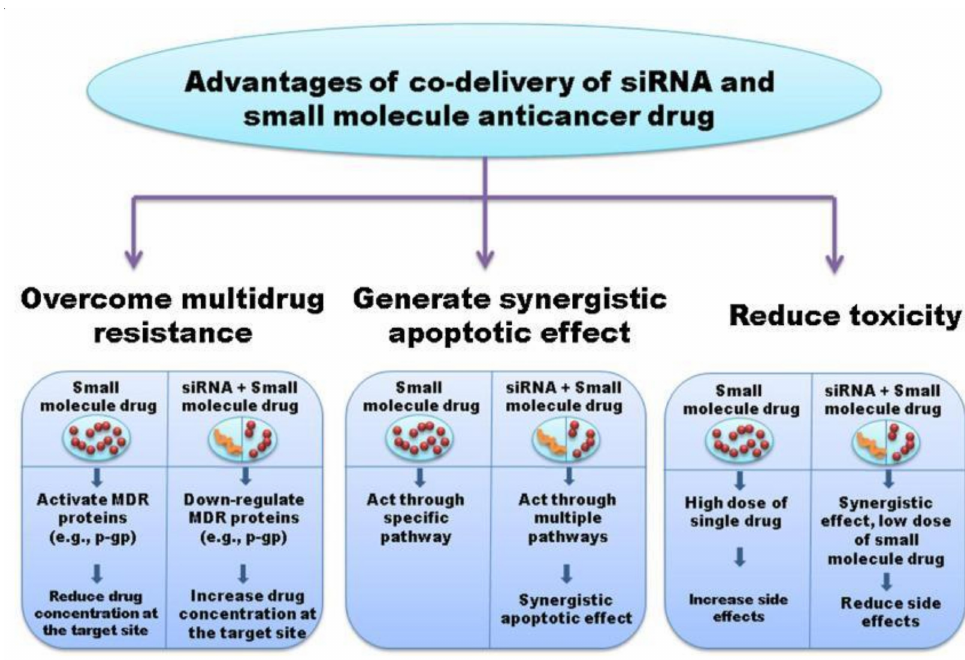
Figure 6. Advantages of combinatorial therapy with RNAi and anticancer agents. Reproduced with permission from Saraswathy, M. et al., Materials Today; published by Elsevier, 2014